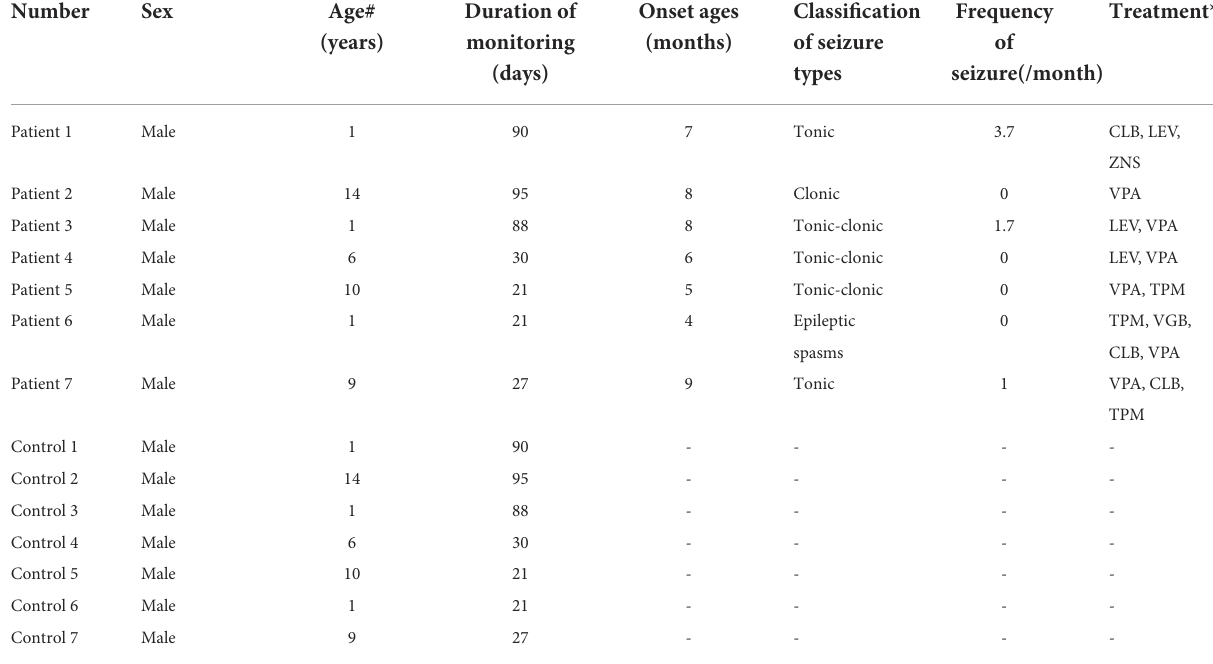
#:TheagecolumnshowedtheageofmonitoringthepHofthechildren. *:CLB,clobazam;LEV,levetiracetam;ZNS,zonisamide;VPA,sodiumvalproate;TPM,topiramate;VGB,vigabatrin.